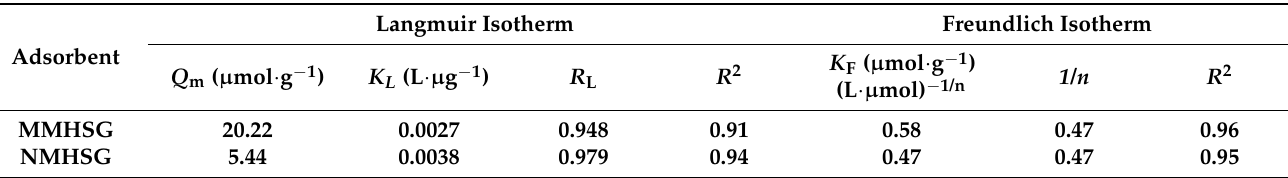
Table 3. Scatchard analysis of the binding isotherms. High-Affinity Binding Adsorbent